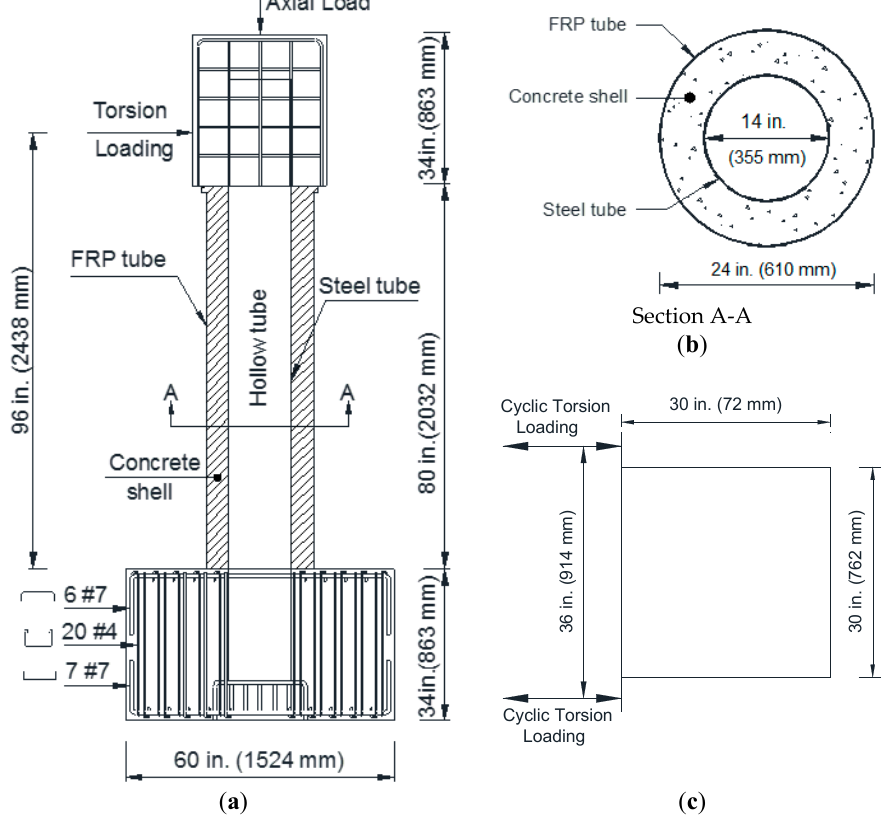
Figure 1. Hollow-core fiber-reinforced polymer–concrete–steel (HC-FCS) column ( a ) Elevation, ( b ) Cross-section, and ( c ) Plan of loading head.